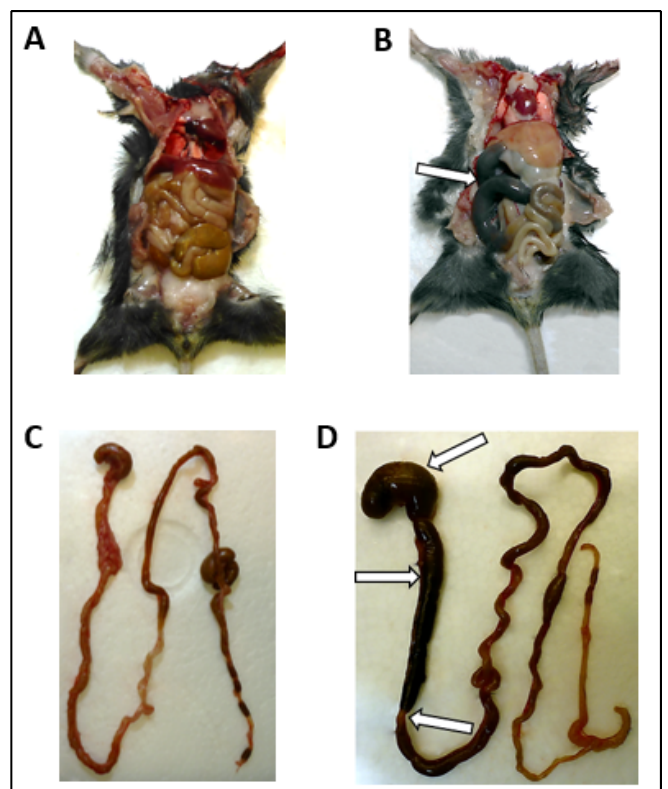
Figure 1. Macroscopic findings of the GI tract from subcutaneously TBEV-infected mice (( B ) M26 at 8 dpi; ( D ) M22 at 10 dpi) and mock-infected control M1 at 14 dpi ( A , C ). Segmental distension and alterations of the small intestine and the stomach are indicated by white arrows. Acute GI tract alterations were found in subcutaneously TBEV-infected mice after 8 dpi.